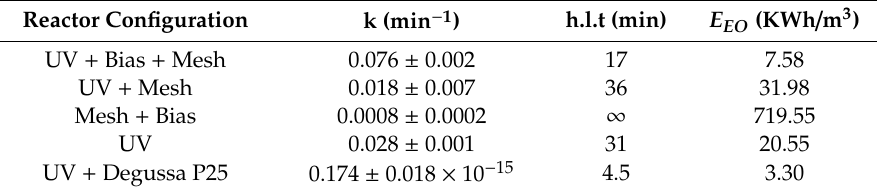
Table 1. Kinetic constants, half-life times and Electrical Energy per Order of magnitude of removal (E EO ) of carbamazepine during degradation by photoelectrocatalysis (UV + Bias + Mesh), photocatalysis using the TiO 2 mesh (UV + Mesh), electrochemical oxidation using the TiO 2 mesh (Mesh + Bias), photolysis (UV) and photocatalysis using commercial TiO 2 powders (UV + Degussa